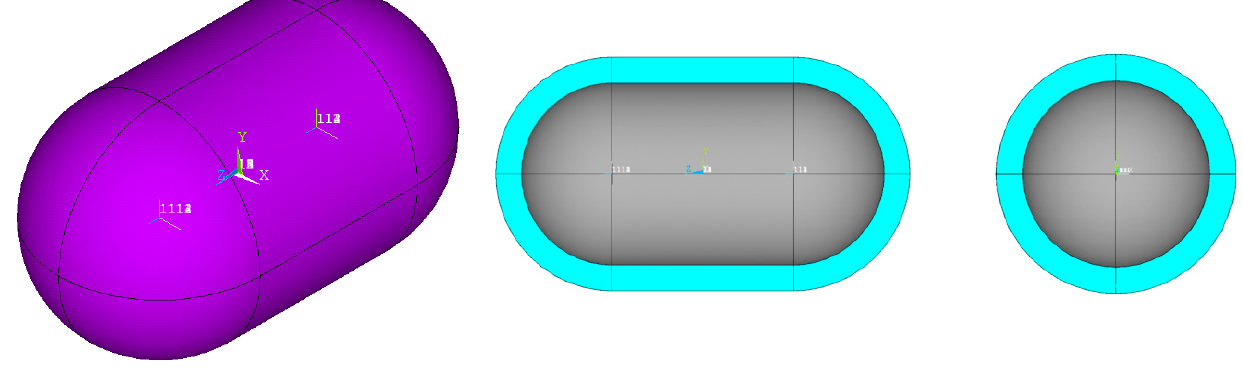
Figure 3. Representation of the tank configuration on which the convergence analysis is performed.